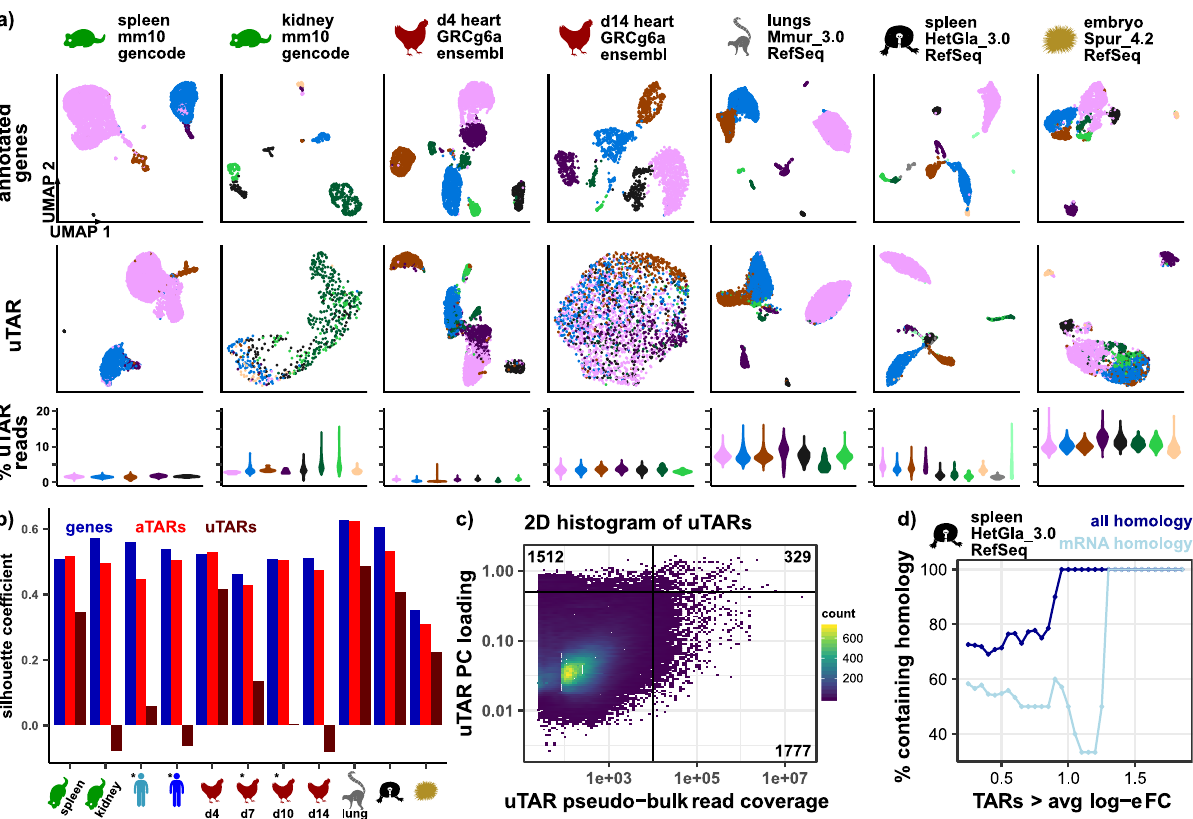
Fig. 2 Reads in uTARs can separate cell types in different organisms. a UMAP dimensional reduction on annotated gene expression features (top row) and uTARs (second row) for mouse spleen, mouse kidney, different time points in chicken embryonic heart development, gray mouse lemur lung tissue, and sea urchin embryonic tissue. Cells are colored in each column based on gene expression clustering. Relative number of uTAR reads for each cell in every cluster also shown as violin plots (third row, colors correspond to UMAPs); 6113 cells in mouse spleen, 610 cells in mouse kidney, 4365 in chicken day 4, 2198 in chicken day 14, 6321 in gray mouse lemur lungs, 2657 in naked mole rat spleen, and 2658 in sea urchin embryo. b Silhouette coef fi cient values based on 2D UMAP coordinates of gene expression (blue), aTARs (red), and uTARs (maroon) for 11 samples. UMAPs for samples labeled with (*) are shown in Supplementary Fig. 1b. Cell labels are de fi ned by gene annotation clustering. c Correlation between top 5 PC loadings and pseudo-bulk read coverage of uTARs across 11 samples. Horizontal line at uTAR PC loading = 0.5, vertical line at uTAR pseudo-bulk read coverage = 1e + 4, r 2 = 4.0e-3. Quadrant numbers represent the number of uTARs in respective quadrant. d Relative percentage of uTARs containing homology to any sequence (blue) and mRNA sequences (light blue) as a function of log-e fold change expression for each cell type in naked mole rat spleen data. BLAST sequence homology results relative to nucleotide collection database thresholds: mean uTAR peak query length = 686 ± 731 bps, uTAR peak percent identity > 71%, e-value< 0.053, bit score > correlation between the total expression level of uTARs (pseudo- bulk read coverage) and their loading values in the fi rst 5 PCs (Fig. 2c, correlation r 2 = 4.0e-3, p -value < 2.2e-16). This analysis indicates that uTARs with high total expression are not necessarily those that best de fi ne cell types, demonstrating the utility of scRNA-seq analysis as a selection fi lter before annotation and validation.